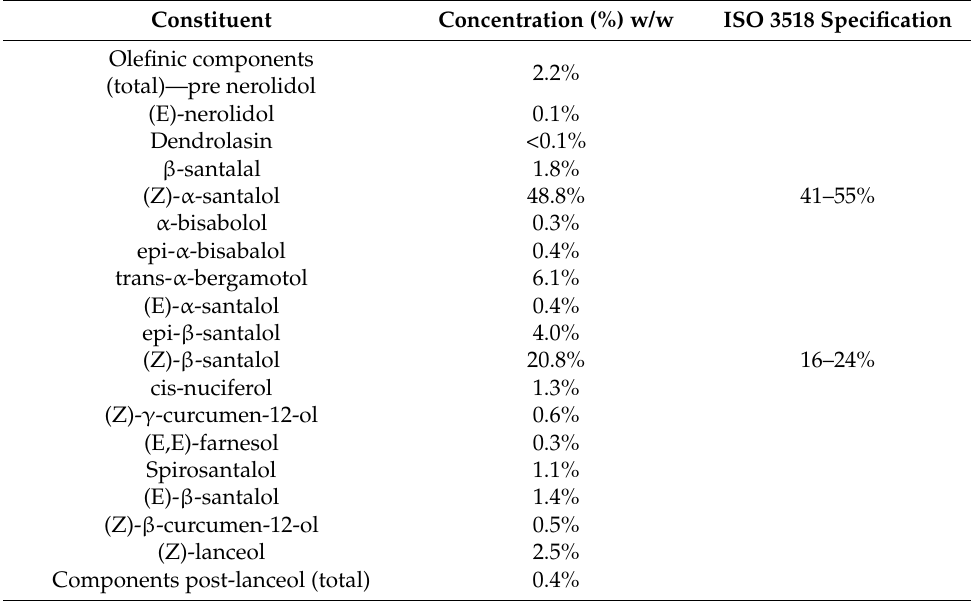
Table 1. Major constituent details from the Indian sandalwood oil